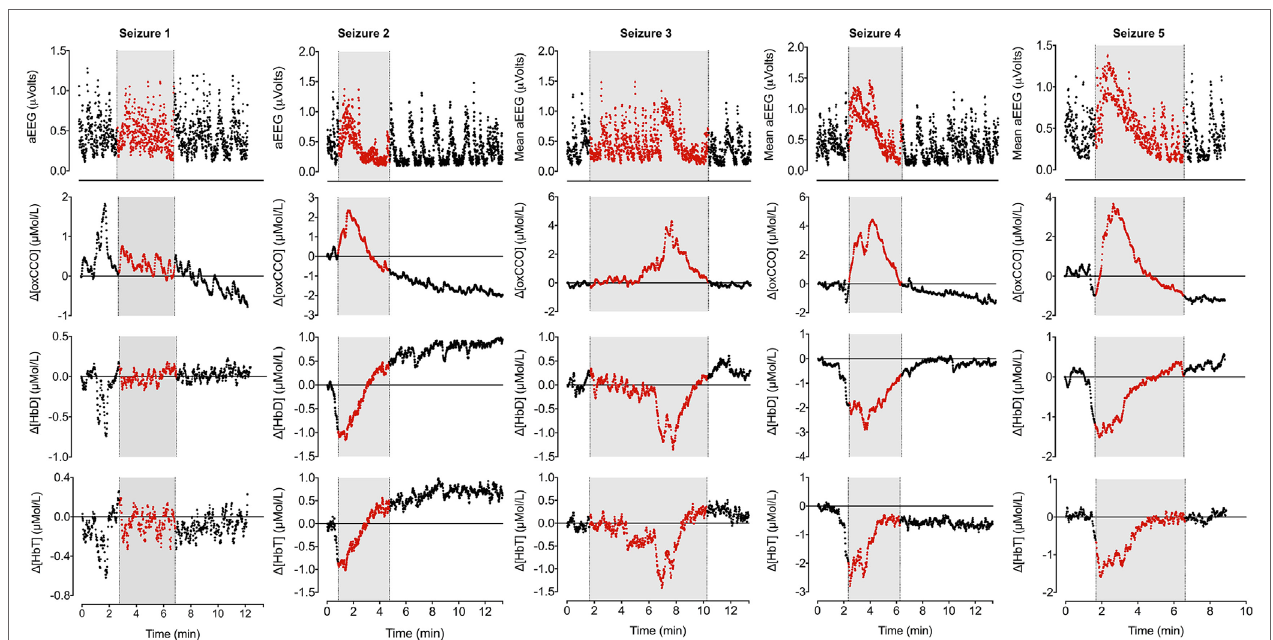
FIGURe 3 | Changes in mean aeeG, Δ [oxCCo], Δ [HbD], and Δ [Hbt] during seizures . Mean aEEG was calculated from F3–C3 channel. NIRS variables have been adjusted to start from 0 on each occasion to reflect the true changes. Periods of electrographic seizures on EEG have been marked in gray and each variable has been marked in red during the seizures. Seizures 2–5 show similar pattern of changes in aEEG, Δ [oxCCO], Δ [HbD], and Δ [HbT]. Δ [oxCCO] increases along with an increase in mean aEEG baseline followed by a drop after peak electrical activity while Δ [HbD] and Δ [HbT] drop early in the preictal period (seizures 2, 4, and 5) and subsequently recover toward baseline. Δ [oxCCO] drops initially in seizures 4 and 5 along with Δ [HbD] and Δ [HbT] but increases with the rise of mean aEEG baseline. Changes in NIRS variables in seizure 1 was similar to other seizures but were noted prior to the onset of electrographic seizure. The first two seizures originated from left posterior hemisphere; the rest were generalized